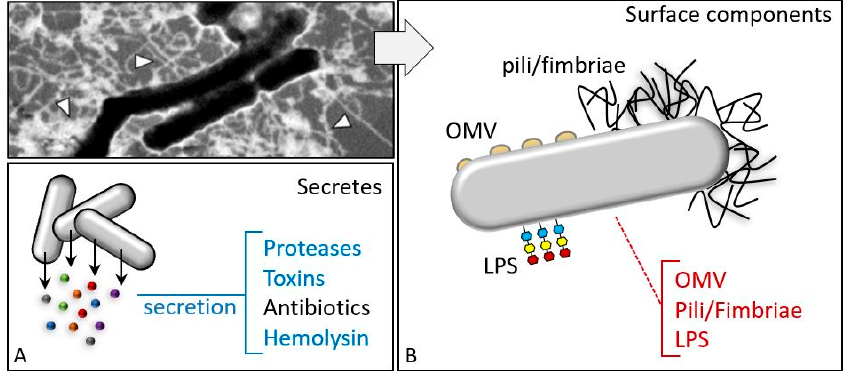
Figure 10. EPN bacterial symbionts have surface components and secretions responsible for evasion / depression strategies. ( A ) Secreted factors, such as proteases, toxins, and hemolysins, interfere with the host immune responses, while antibiotic compounds are synthesized and released to prevent the growth of possible competing bacteria. ( B ) Surface components and secretions from entomopathogenic bacteria, lipopolysaccharides (LPS), pili / fimbriae components, or outer membrane vesicle (OMV) content and membrane components are responsible for various immunodepression and immunoevasion processes. Transmission electron micrograph shows X. nematophila surface structures after negative staining.